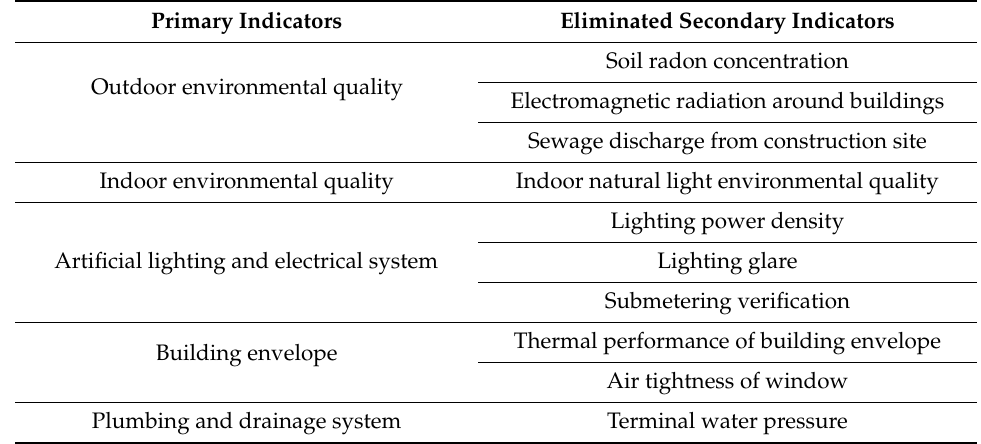
Table 9. Estimated indicators based on the two principles proposed in the Section